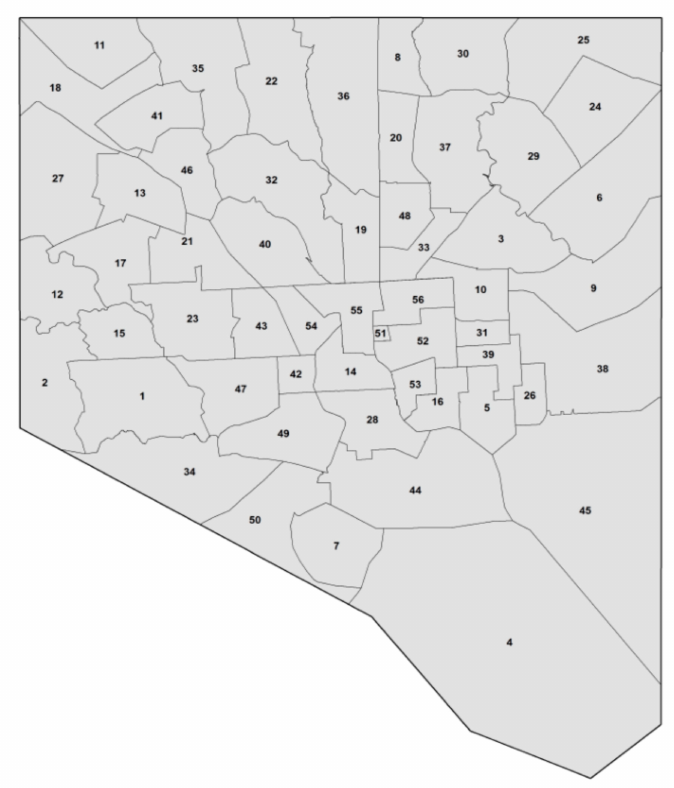
Figure 2. Community statistical areas (CSAs) in Baltimore, MD (n = 55). The Baltimore City Detention Center is identified as 51 but is not a designated CSA, therefore, is excluded from the CSA count